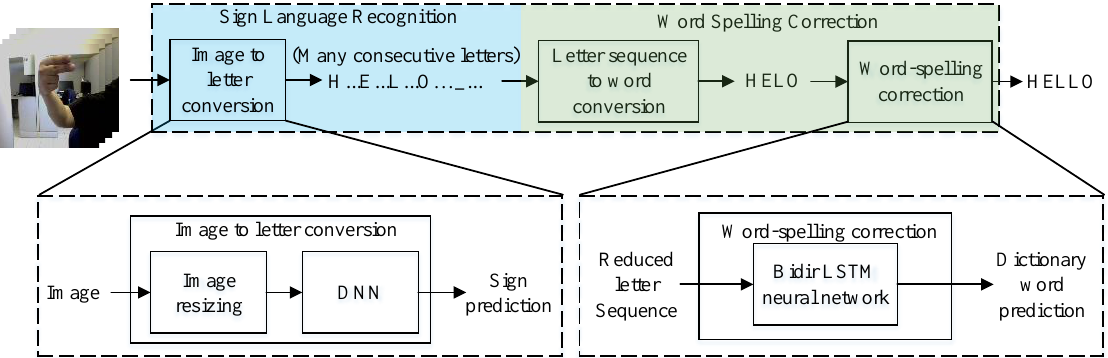
Figure 1. Processing stages of proposed American Sign Language alphabet translator.